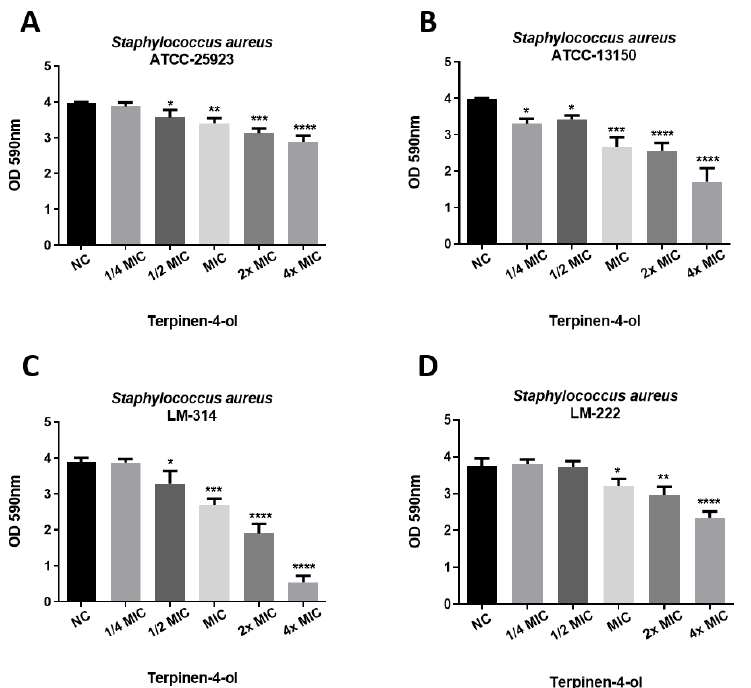
Figure 4. Effect of terpinen-4-ol on preformed biofilms by different S. aureus strains : ( A ) ATCC-25923; ( B ) ATCC-13150; ( C ) LM-314; ( D ) LM-222. NC: negative control. Statistical analysis compared to the negative control: **** p ≤ 0.0001; *** p ≤ 0.001; ** p ≤ 0.01, * p ≤ 0.05.